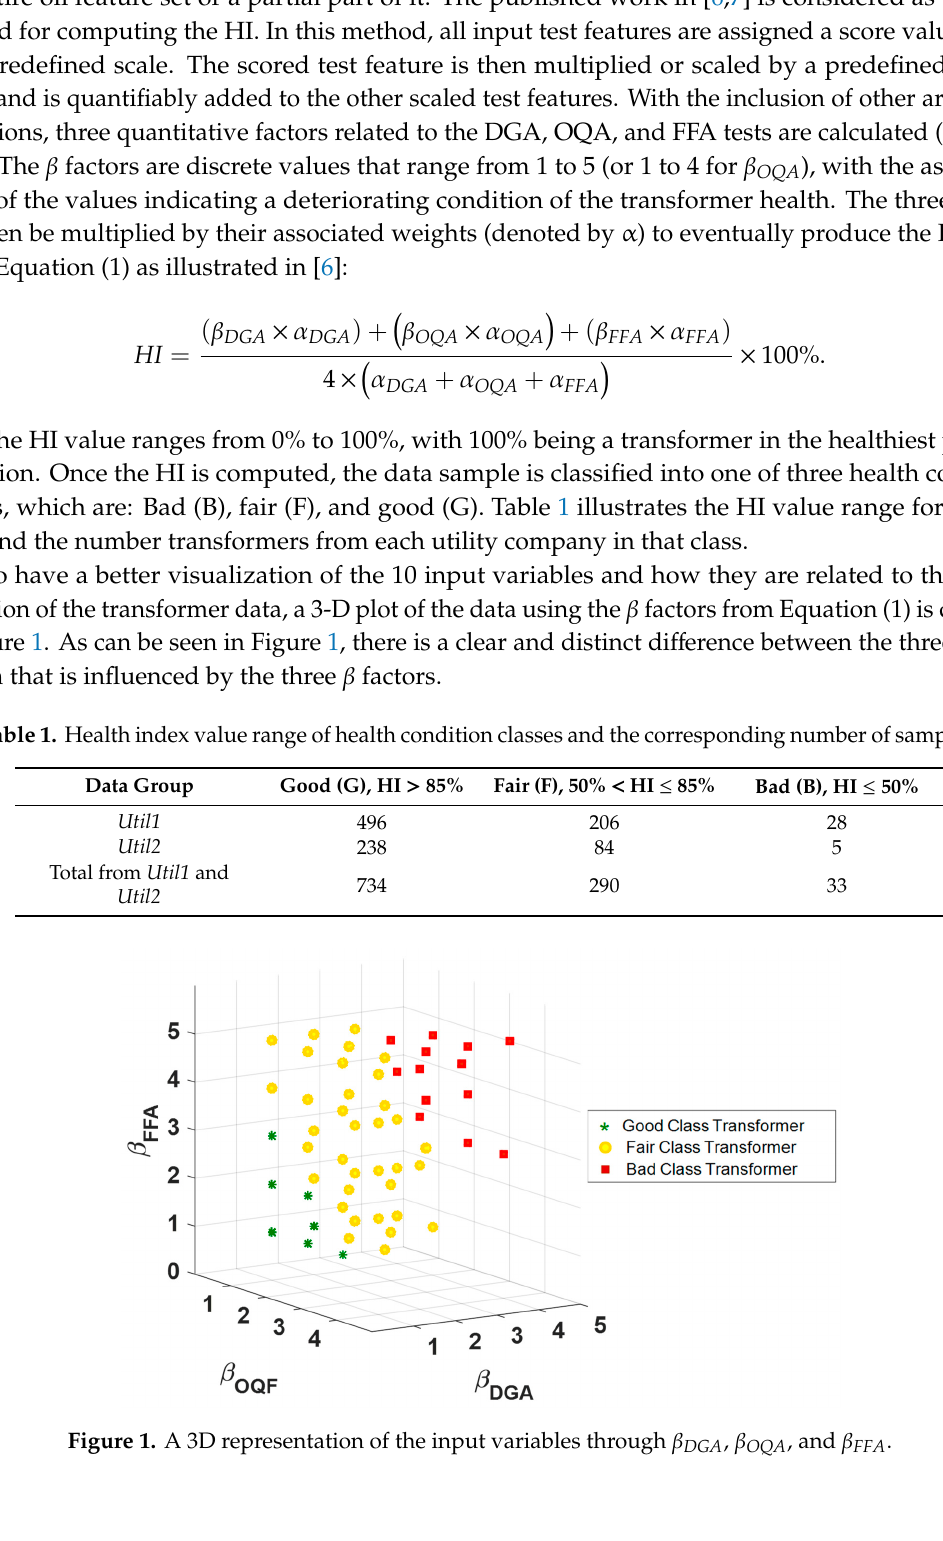
Figure 1. A 3D representation of the input variables through 𝛽 (cid:3005)(cid:3008)(cid:3002) , 𝛽 (cid:3016)(cid:3018)(cid:3002) , and 𝛽 (cid:3007)(cid:3007)(cid:3002) .